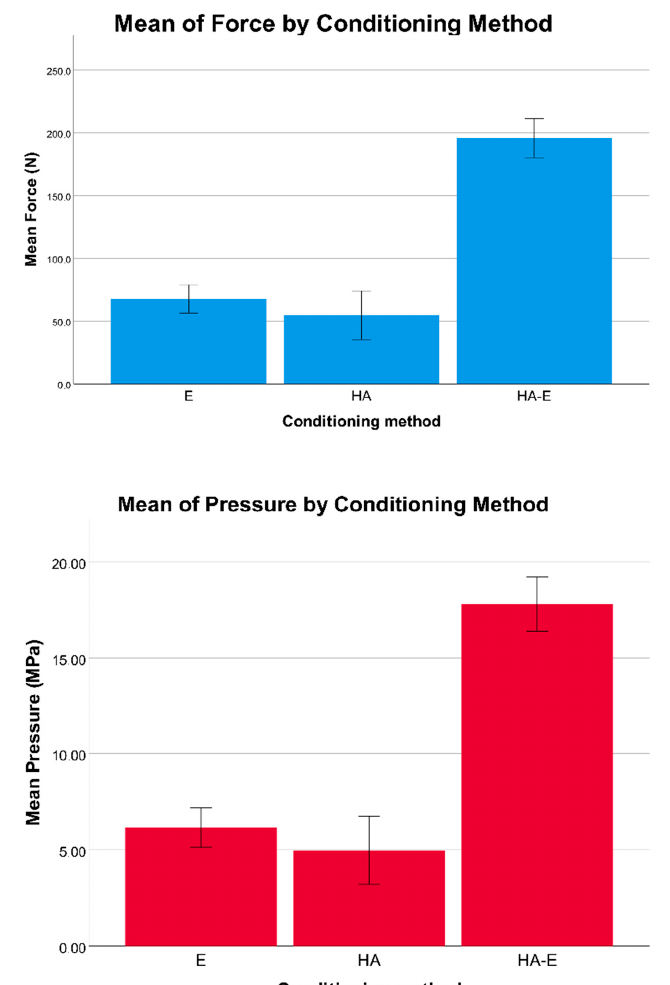
Figure 6. Histograms reporting the mean values of shear bond force (N) and pressure (MPa) respectively, for the acid etching (E) group, for the hydroabrasion group (HA), and for the hydroabrasion and acid etching (HA-E) group. The 95% confidence interval is reported as error